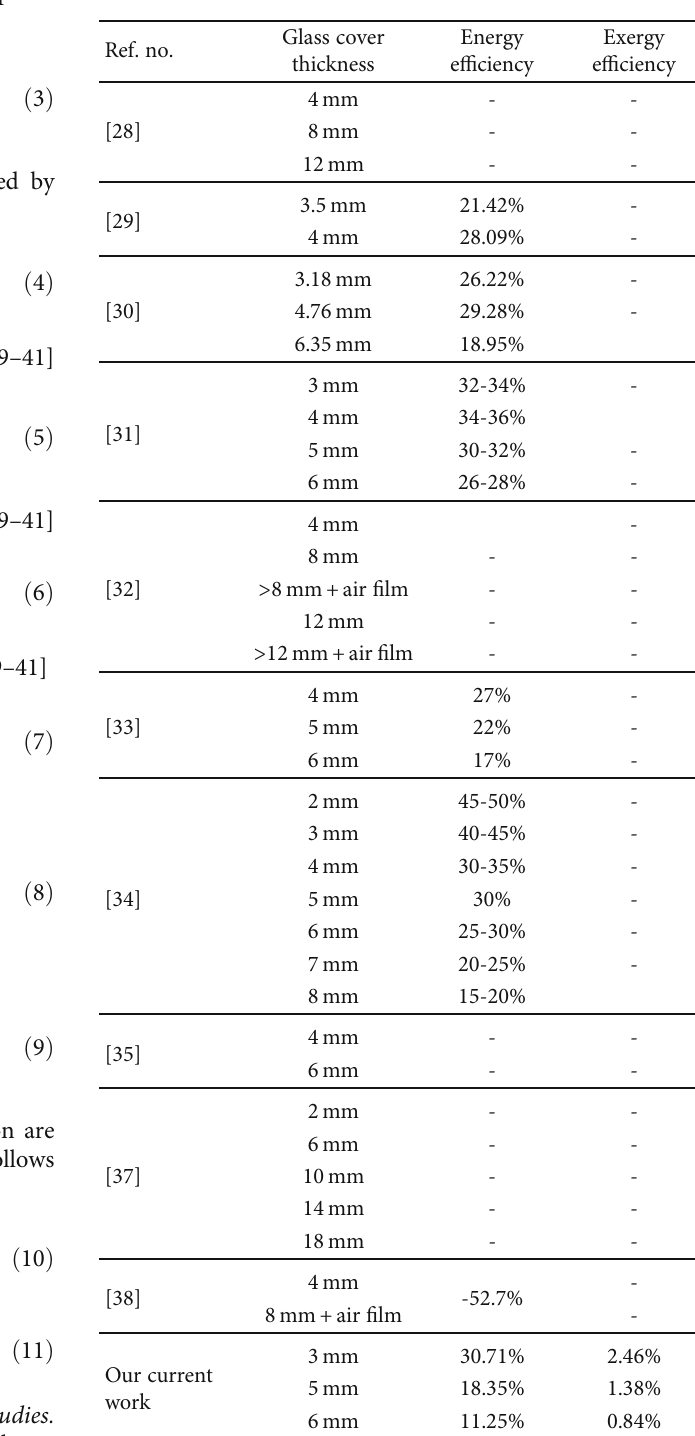
Table 2: Summary of various researchers on the glass cover